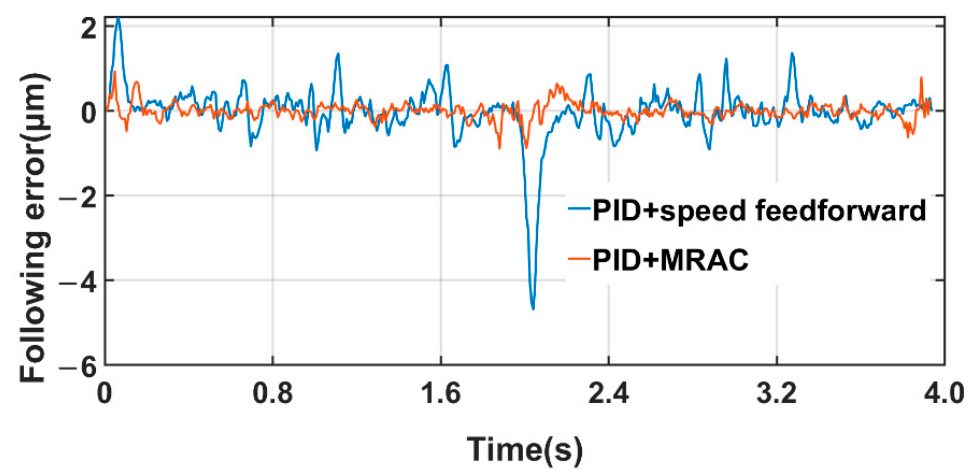
Figure 17. Comparison of following error of the two methods.